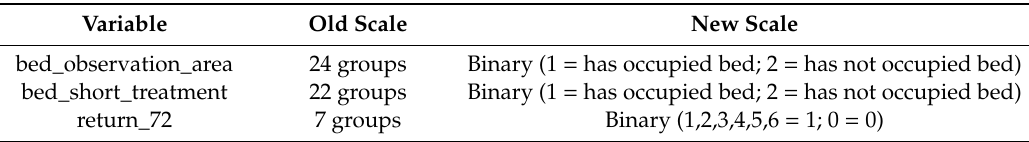
Table 5. Variable interval